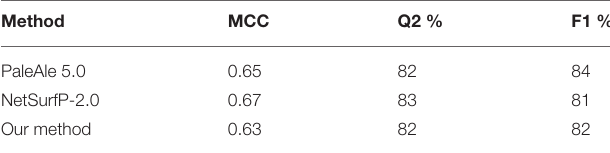
TABLE 4 | Performance of different methods for solvent accessibility prediction on the blind test set described in this study comprising 200 protein sequences.